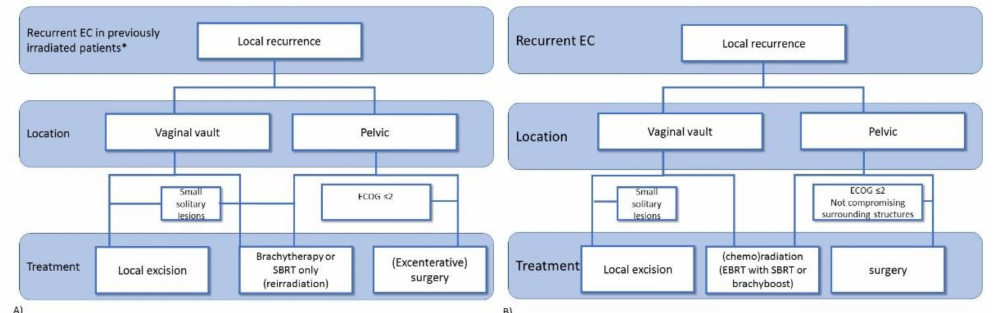
Figure 2. Flow chart for possible treatment decisions in patients with recurrent endometrial cancer after initial surgical treatment with ( A ) or without ( B ) previous adjuvant locoregional radiotherapy. EBRT: external beam radiotherapy; SBRT: stereotactic body radiotherapy. * excluding adjuvant brachytherapy